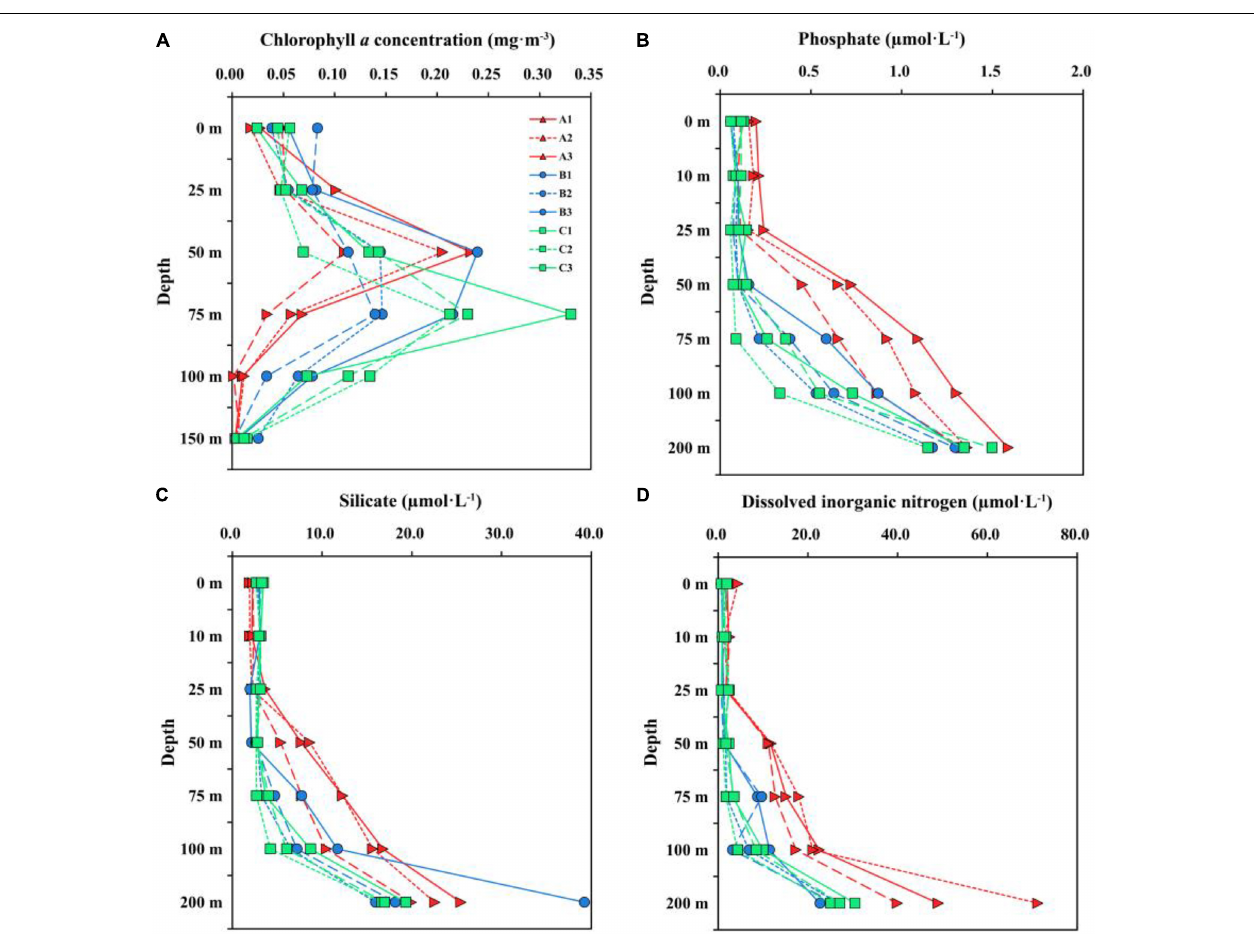
FIGURE 3 | Vertical distribution of chlorophyll- a concentration (A) above 150 m and nutrient concentrations [ (B) phosphate; (C) silicate; (D) dissolved inorganic nitrogen] above 200 m for three transects.